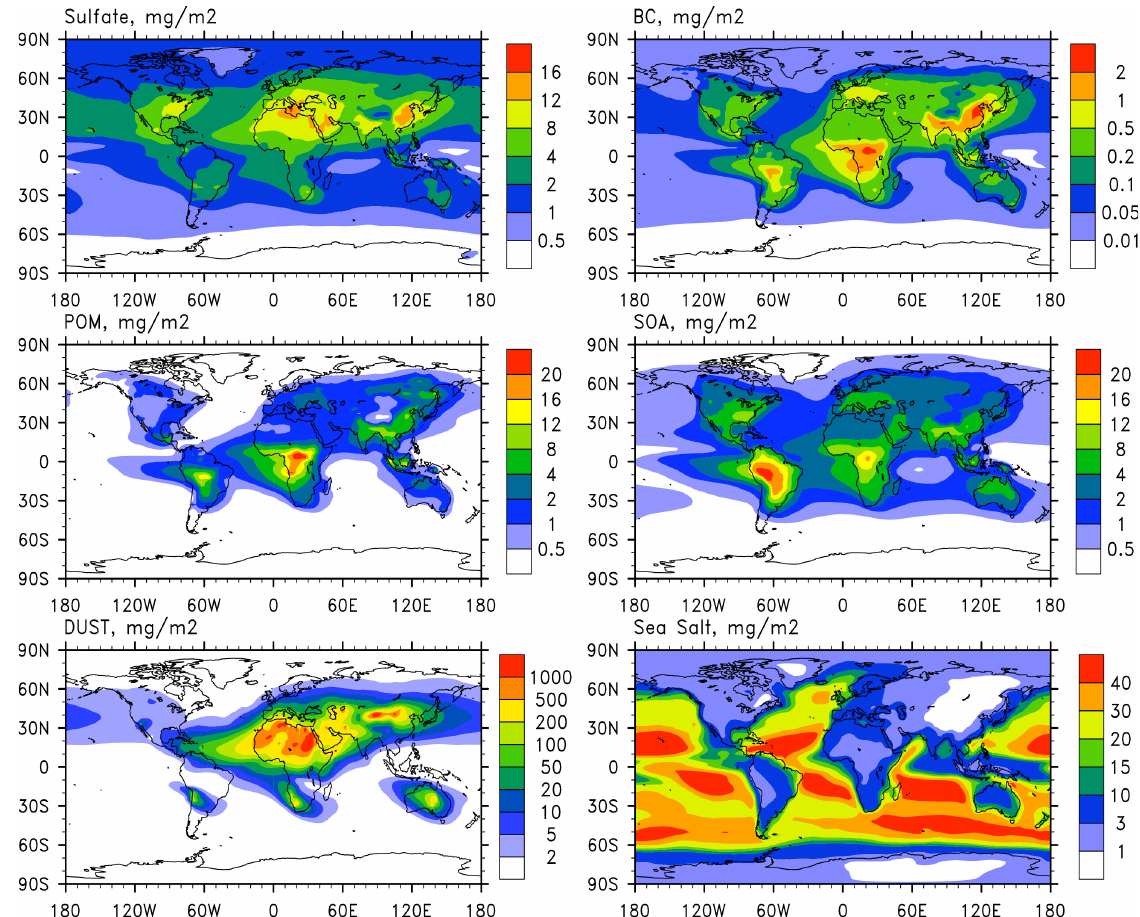
Fig. 3a. Annual mean vertically integrated concentrations (mgm − 2 ) of sulfate, BC, POM, SOA, dust, and sea salt from Figure 3a. Annual mean vertically integrated concentrations (mg m -2 ) of sulfate, BC, POM, SOA, dust, and sea salt from MAM3.